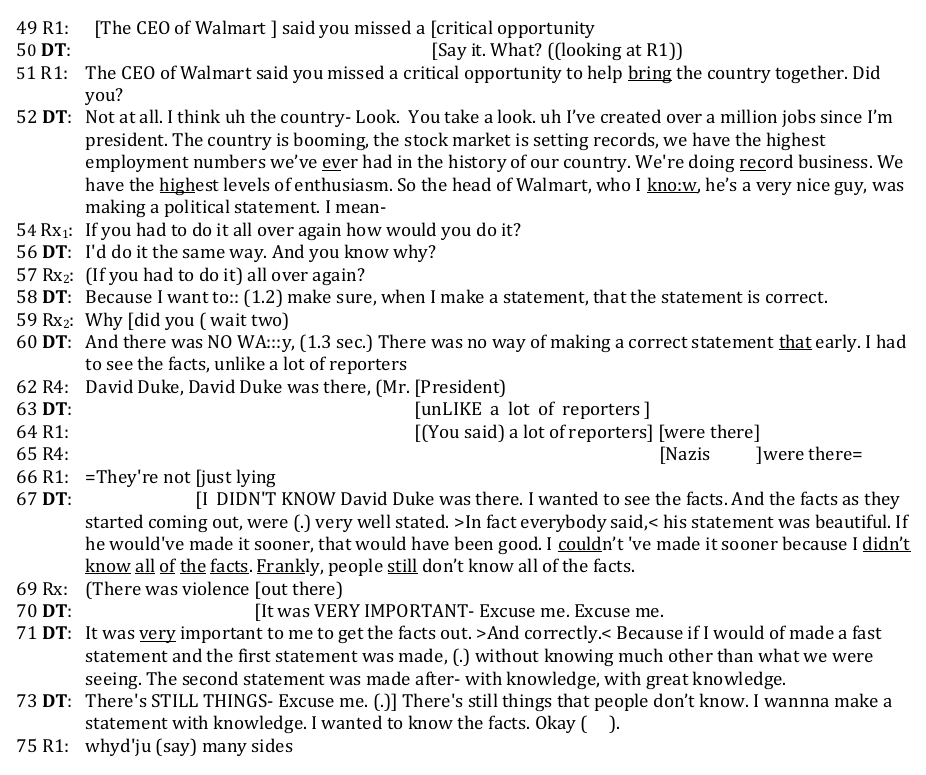
Figure 7. Transcript excerpt 49–75.